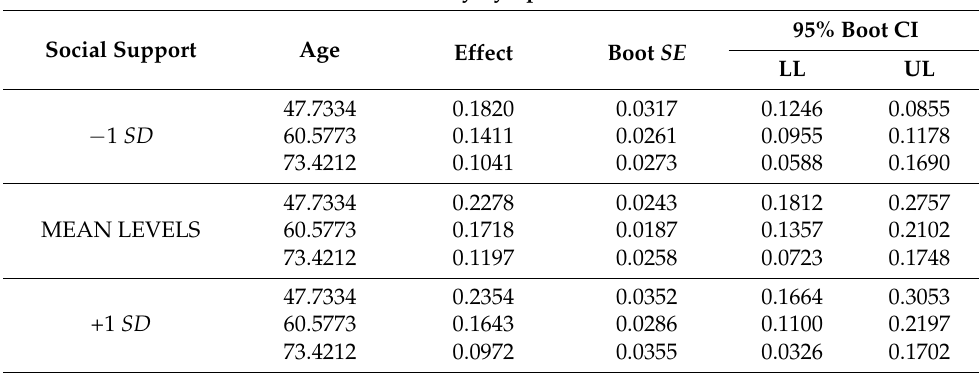
Table 3. Bootstrap Estimates for Moderated Mediation Effects. Conditional Indirect Effects of Distress on PTSS at Values of the Moderators (Mediated by Symptom